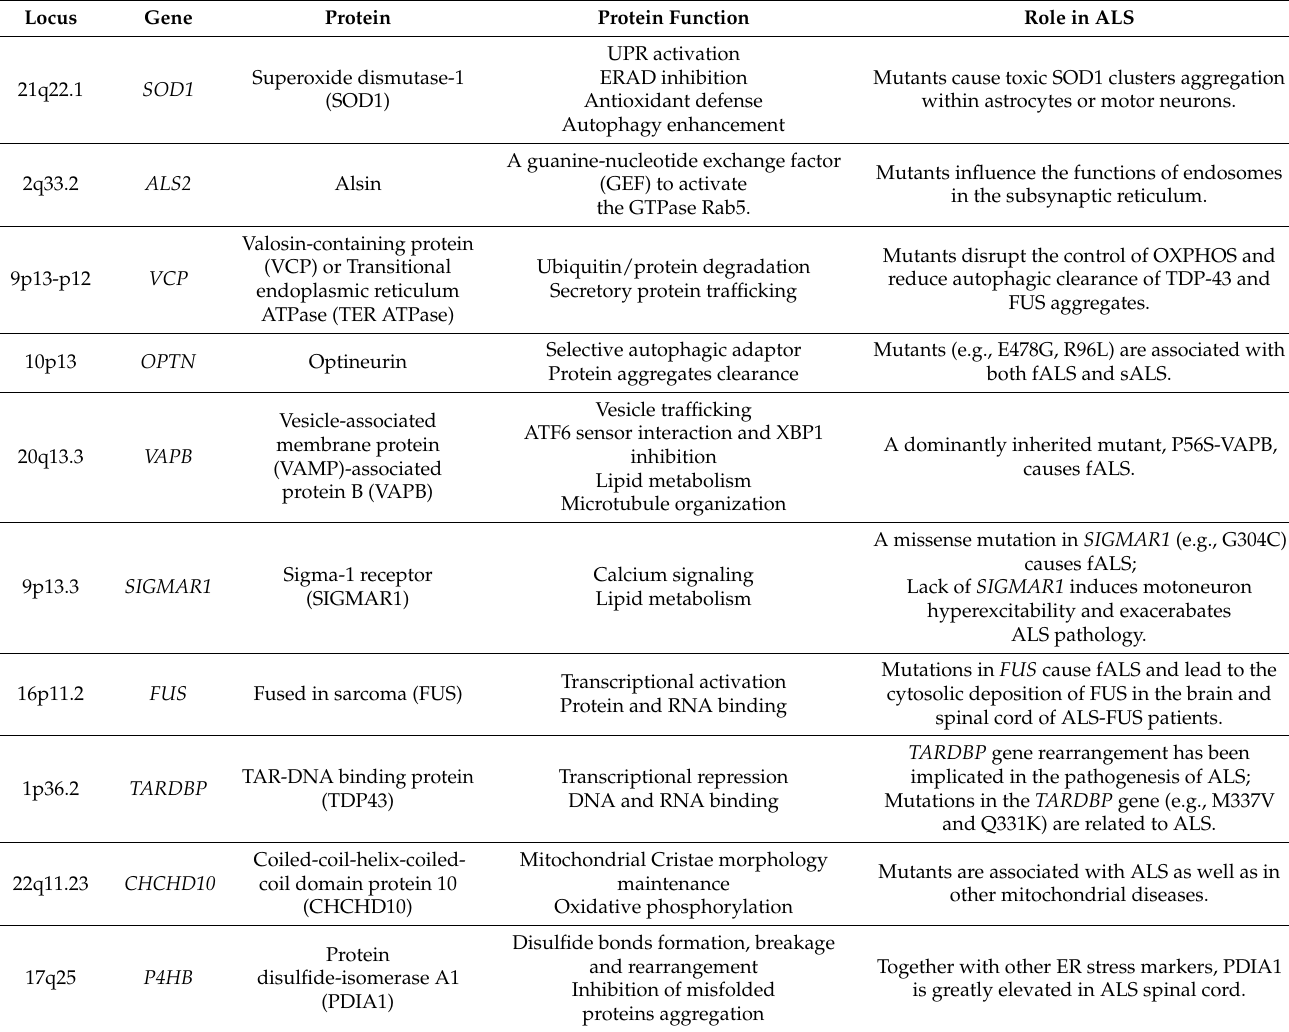
Table 1. MCS-associated genes mutated in